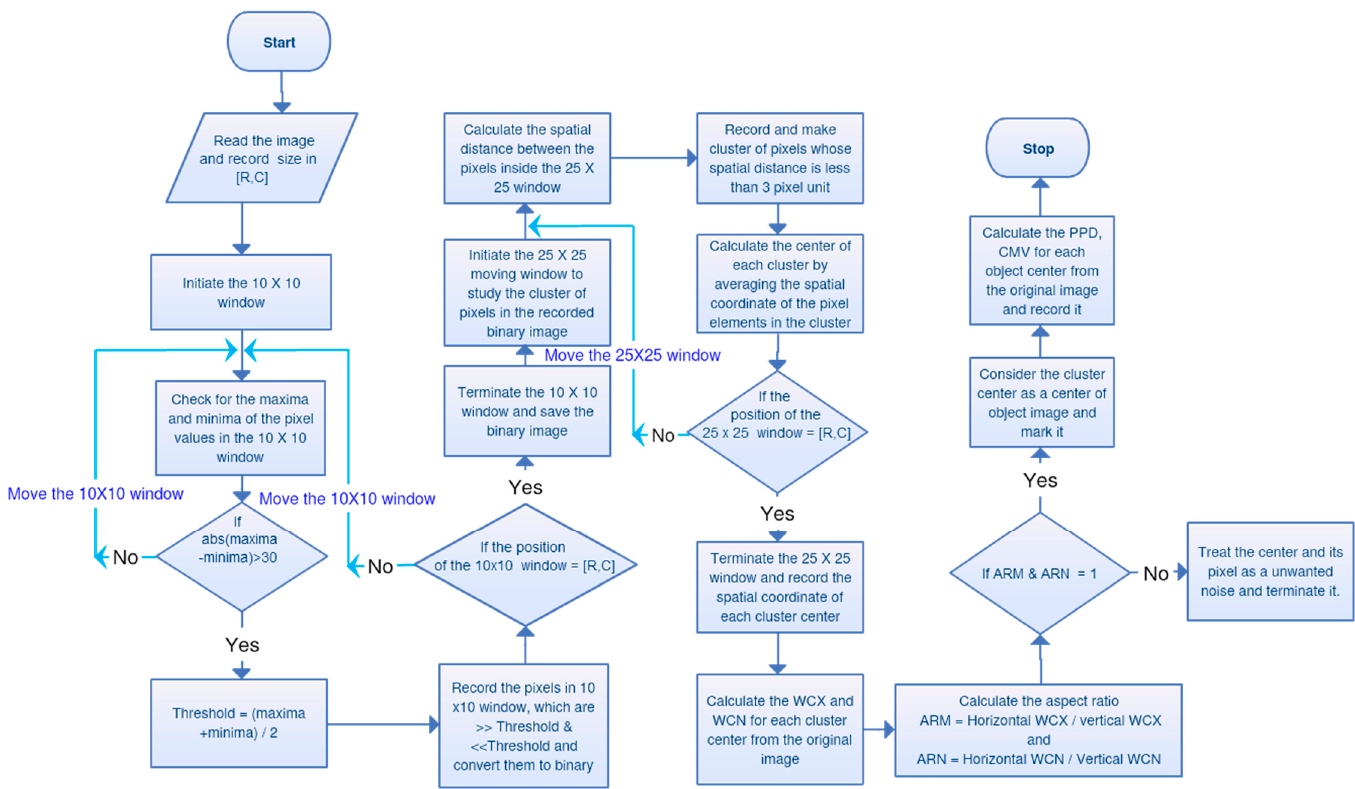
Figure 6. Concise flowchart of the algorithm.